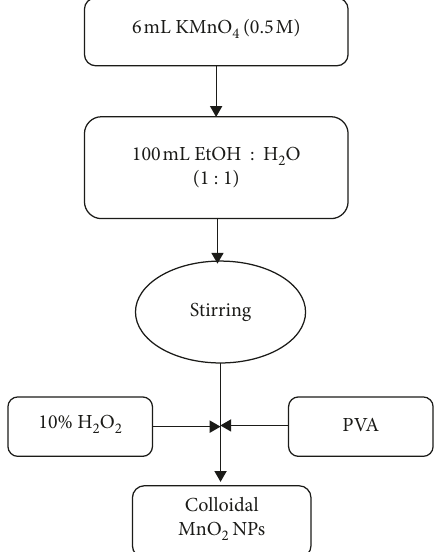
Scheme 1: Synthesis of colloidal MnO